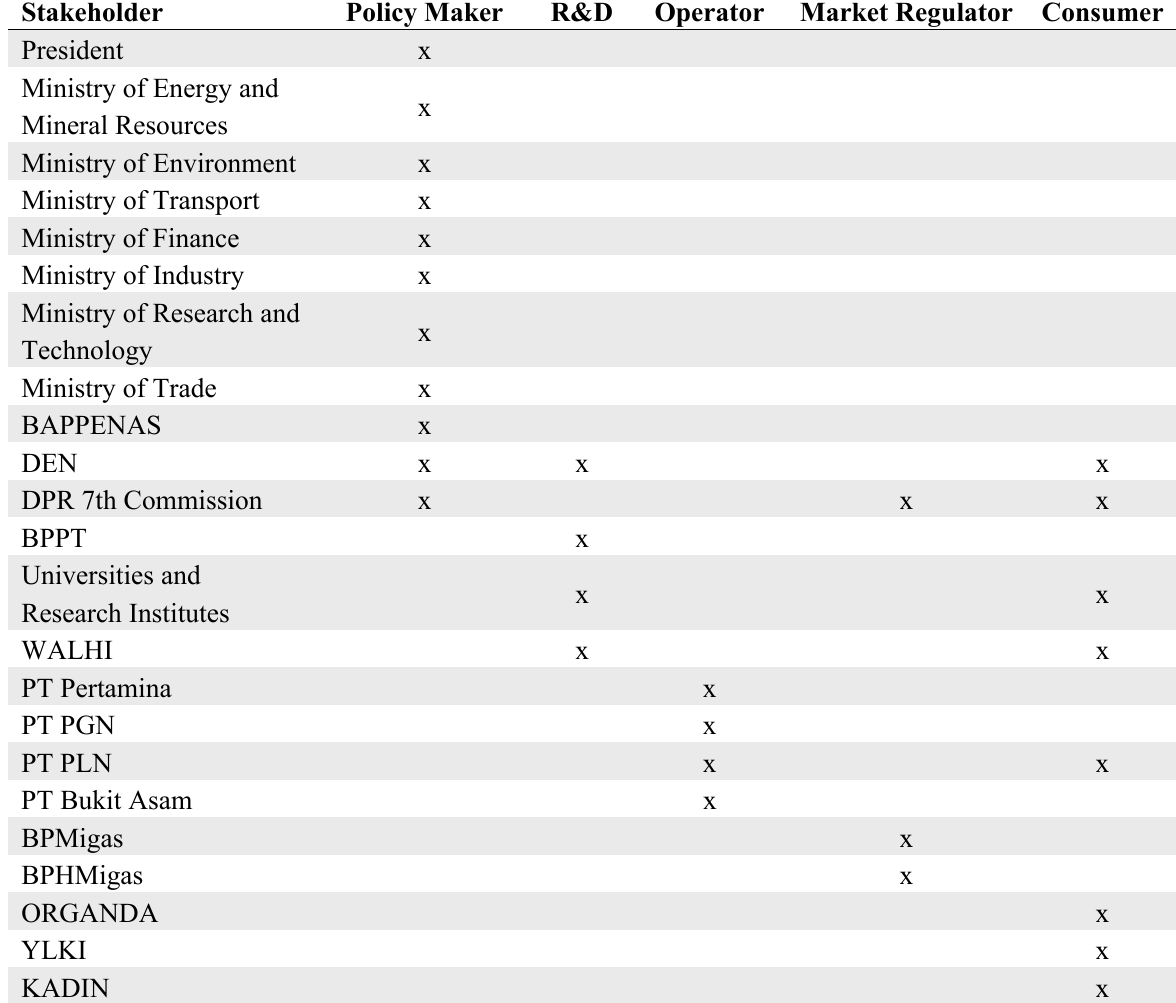
Table 1. Identified stakeholders and their